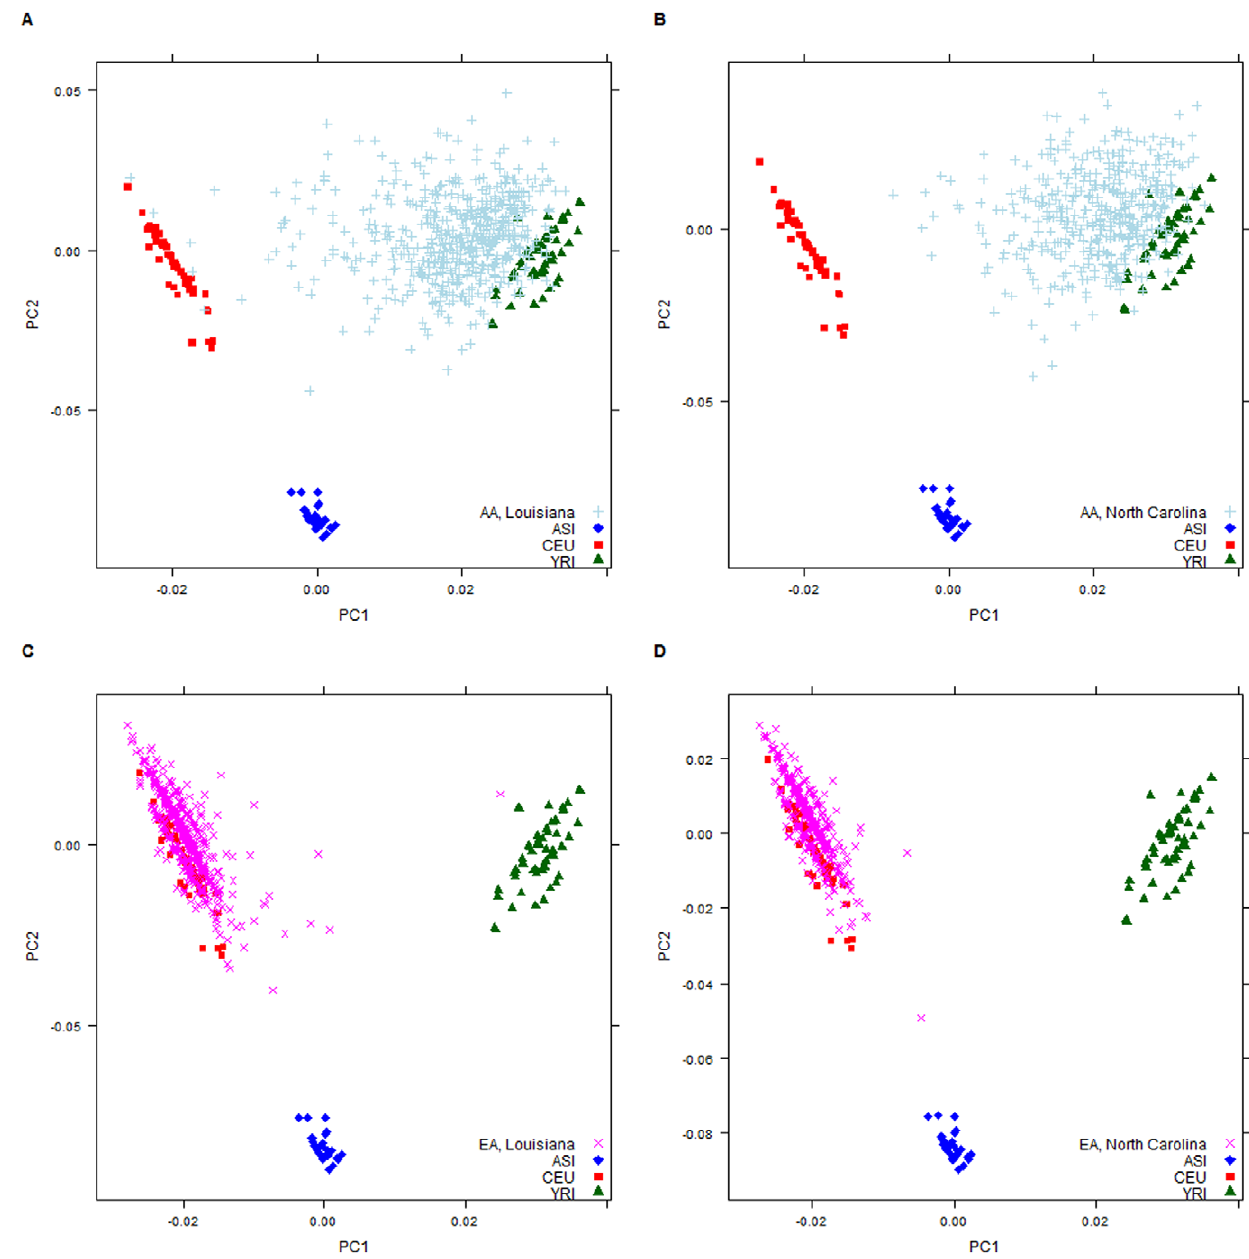
Figure 1. Clustering of self-reporting AA and EA research subjects and HapMap CEU, YRI, ASI (JPT + CHB) populations based on PC1 and PC2. Plots of AA and EA research participants in Louisiana ( a,c ) and North Carolina ( b,d ).